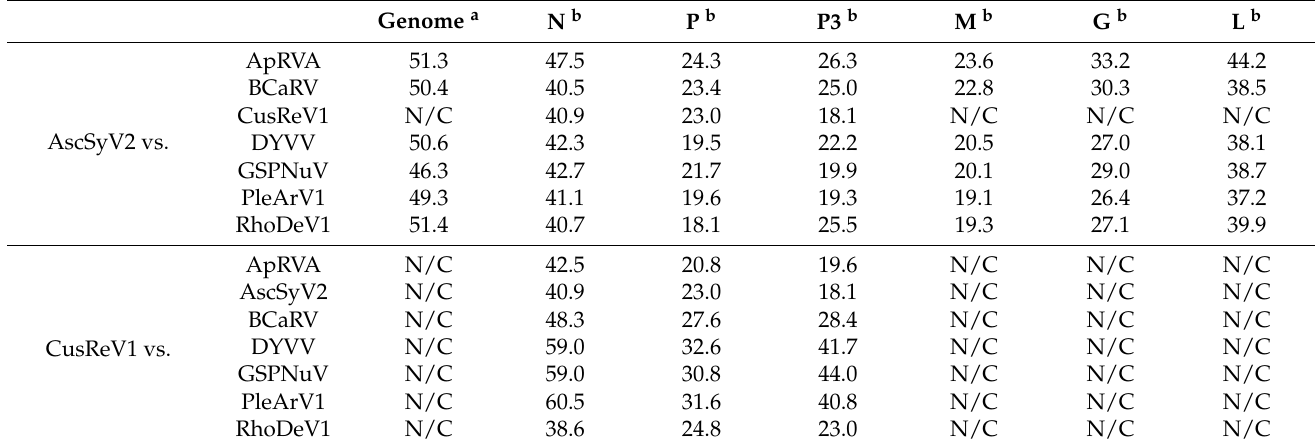
Table 4. Pairwise identity percentages between AscSyV2, CusReV1, PleArV1 and RhoDeV1 and the selected betanucle- orhabdoviruses.